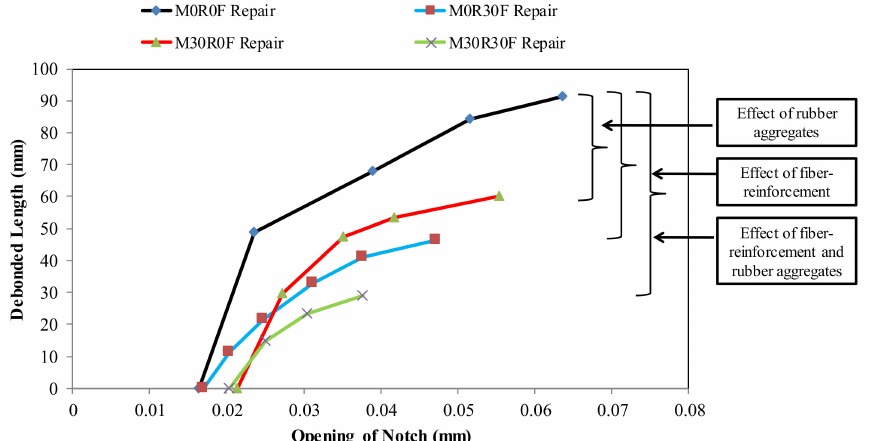
Figure 20. Debonded length vs. notch opening for different repair